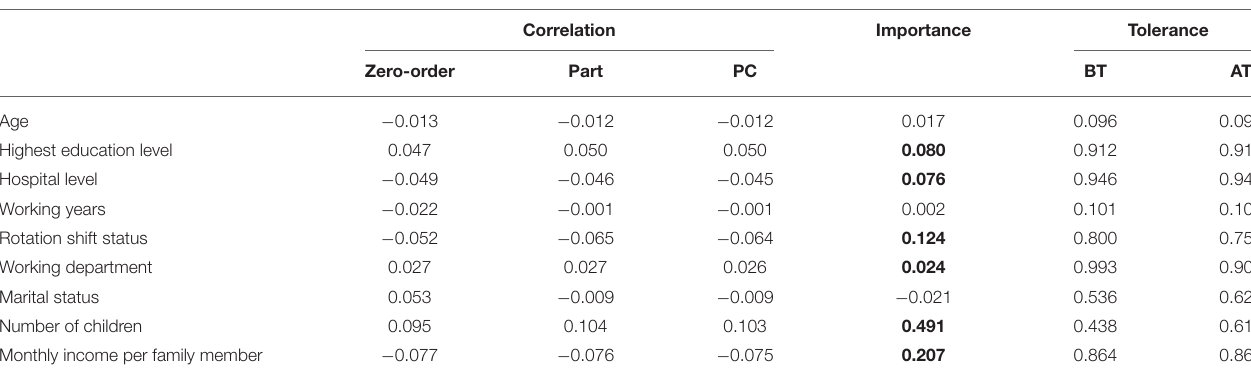
TABLE 4 | The outcome of Correlation and